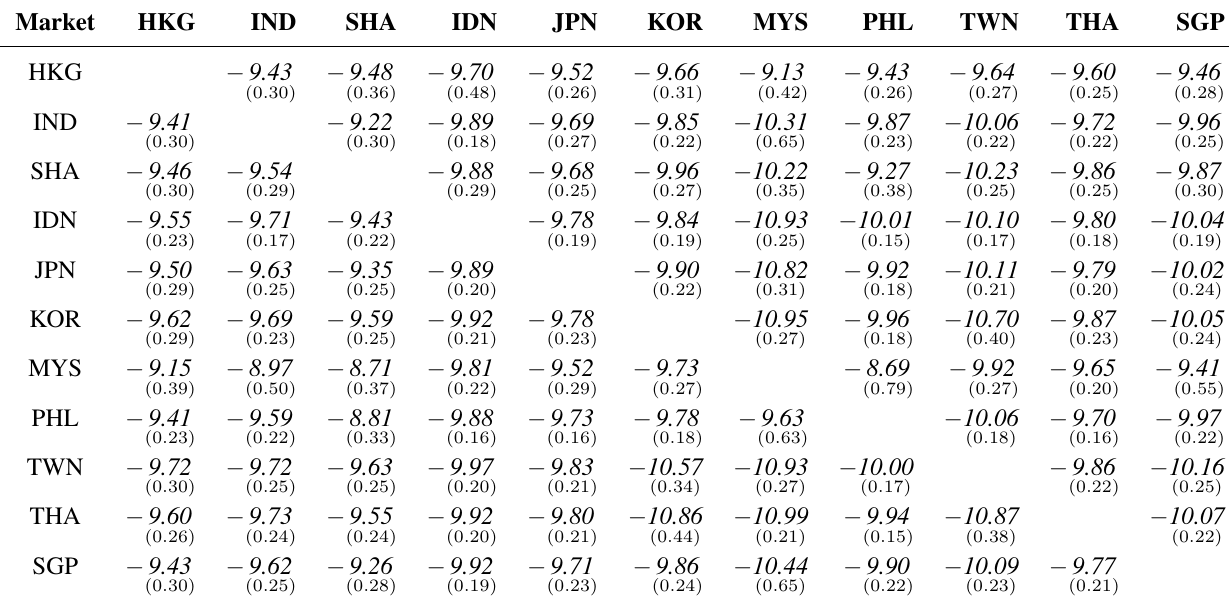
Table 9. Estimation results of  2 in the bivariate SV model.